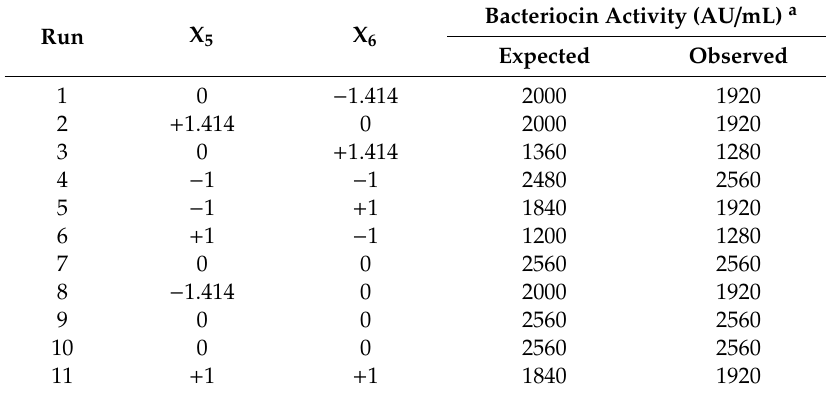
Table 7. CCD design and response values.